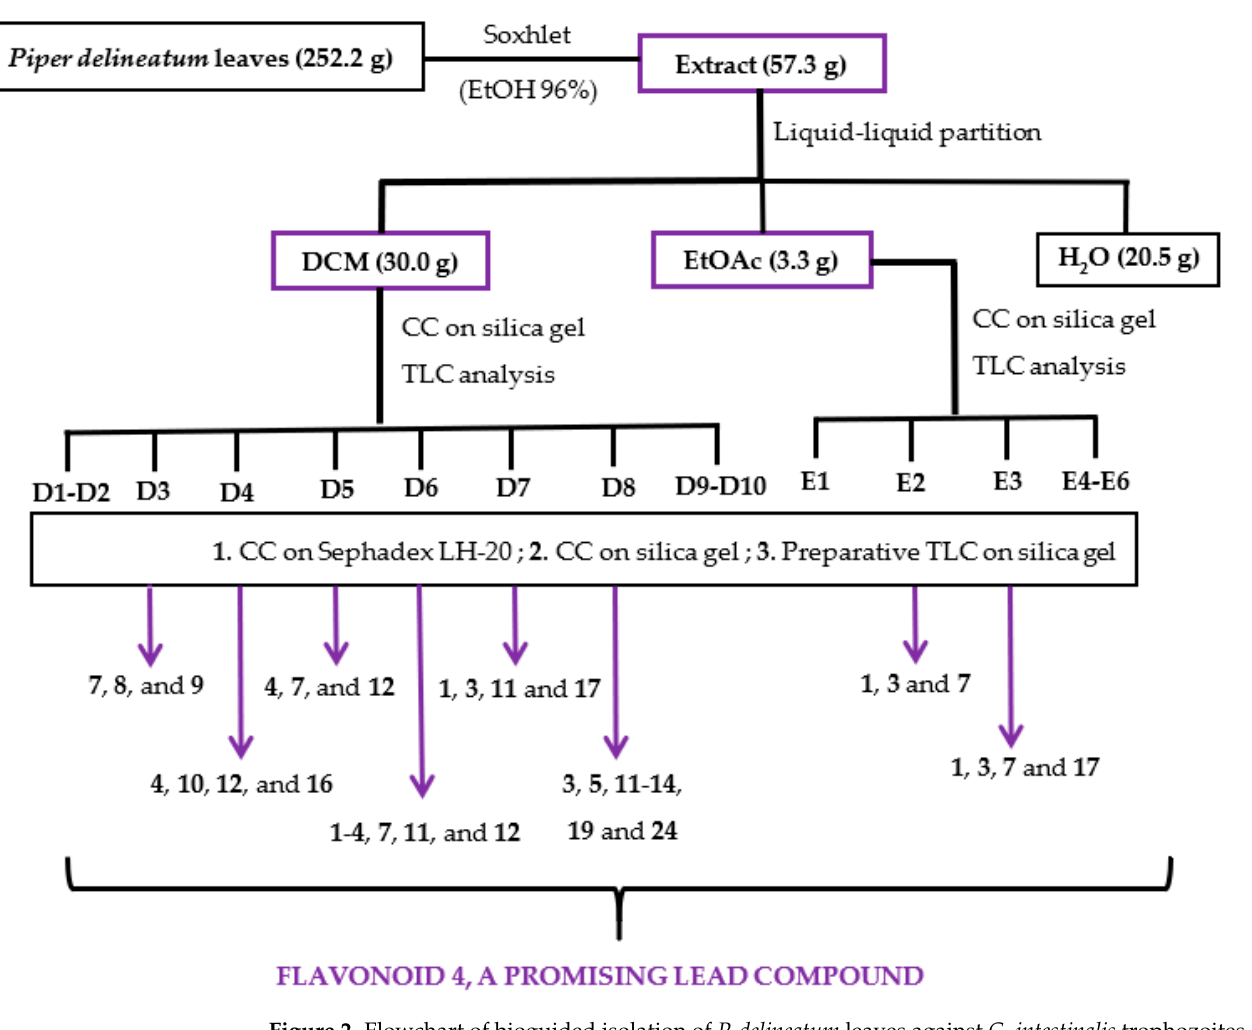
Figure 2. Flowchart of bioguided isolation of P. delineatum leaves against G. intestinalis trophozoites. Table 3. Activity against trophozoite stage of Giardia intestinalis and cytotoxicity against the murine macrophage J774 cell line of crude extract, fractions, and sub-fractions from Piper delineatum leaves. Extract or Fractions